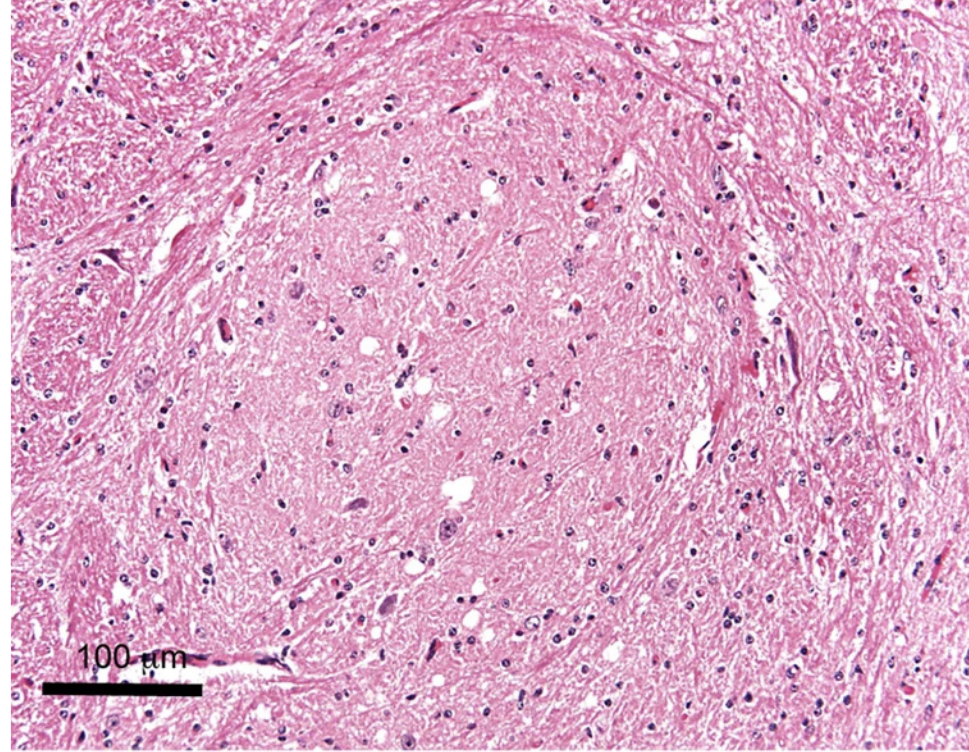
Figure 1. Hematoxylin and eosin staining, the nucleus of the solitary tract of H-type BSE: the presence of spongiosis in the neuropil (100 µm). Reprinted from Ref. [18].